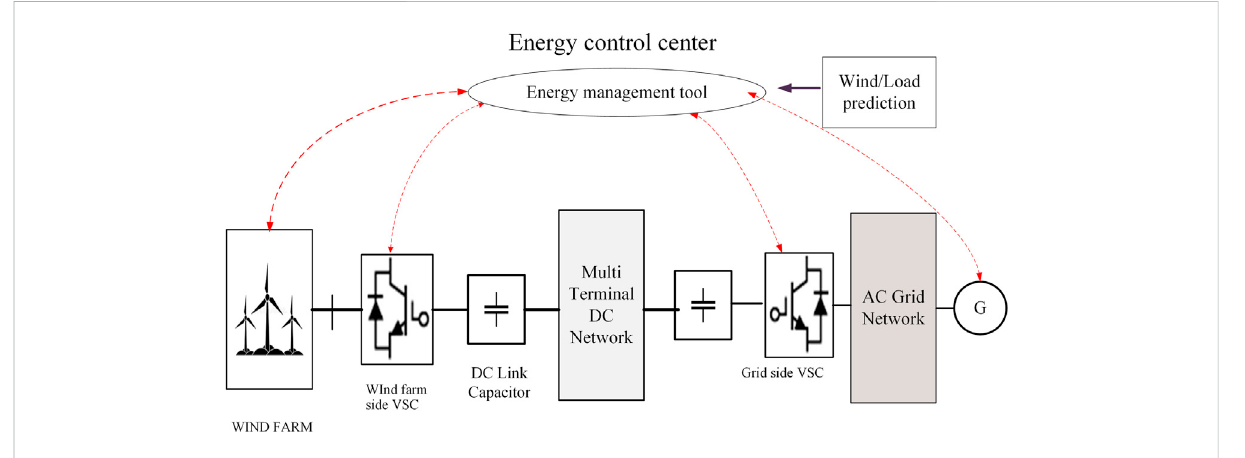
FIGURE 5 AC-VSC-based MTDC system ’ s integrated con fi